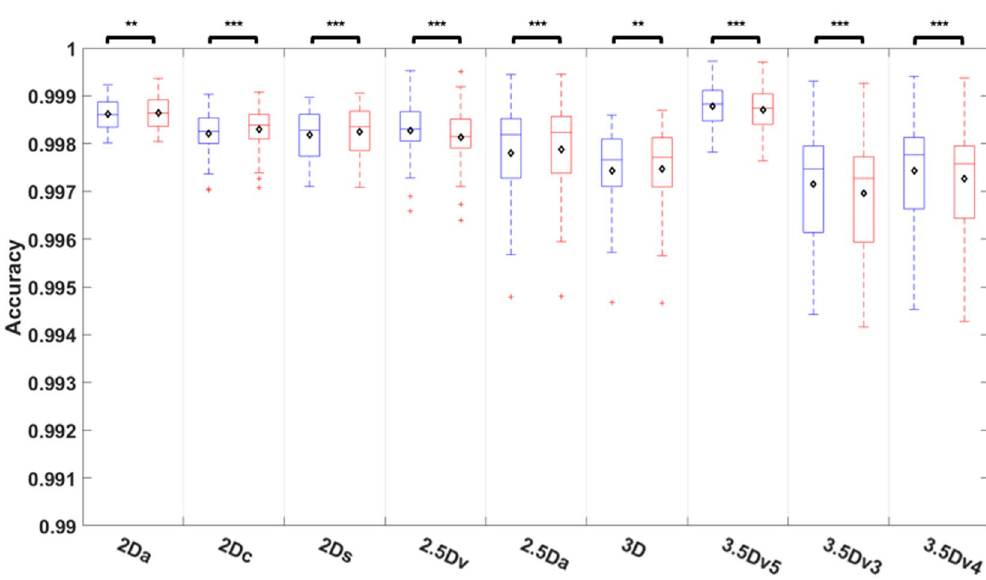
Figure 5. Comparison of accuracy among 9 U-Nets before and after